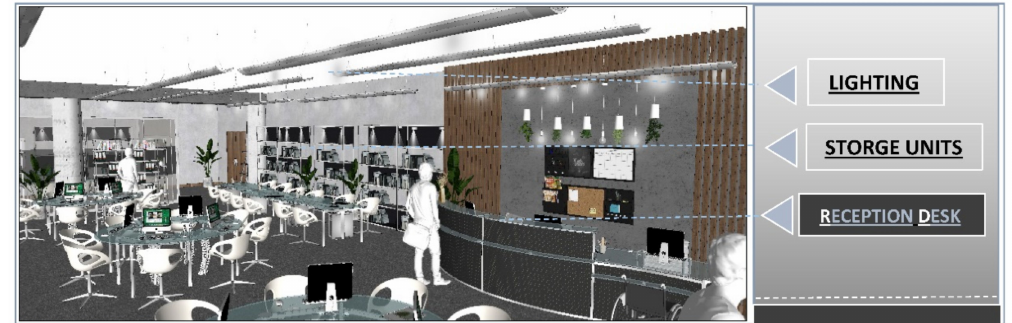
Figure 10. Internal perspective shows reception and seating units.